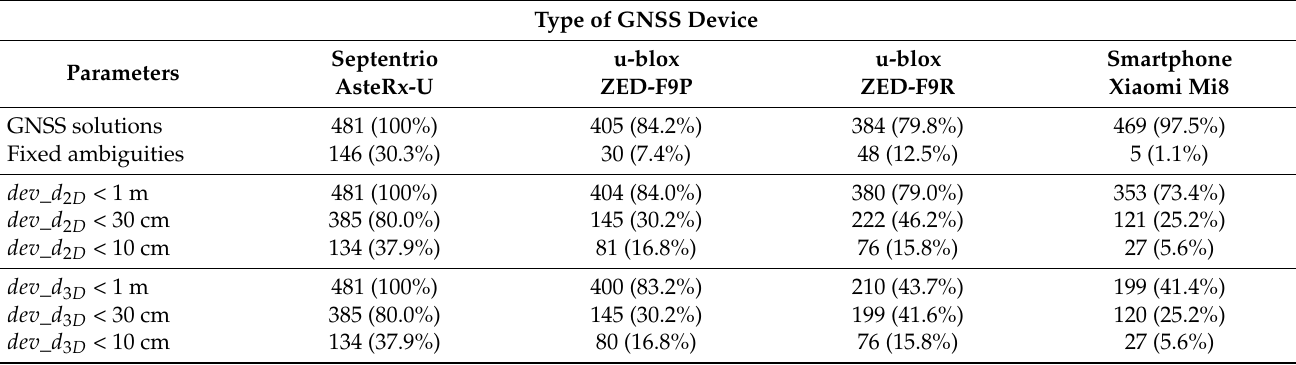
Table 12. GNSS solutions, solutions with fixed ambiguities, and deviation of distances below the given threshold. threshold Situation: Case C—serpentines (no. of total solutions: